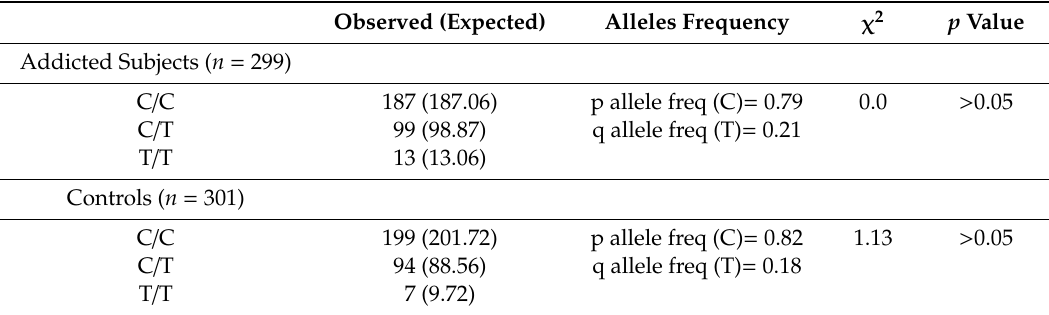
Table 1. Hardy-Weinberg equilibrium of the ANKK1 Taq1A alleles frequency in a group of addicted subjects and controls.